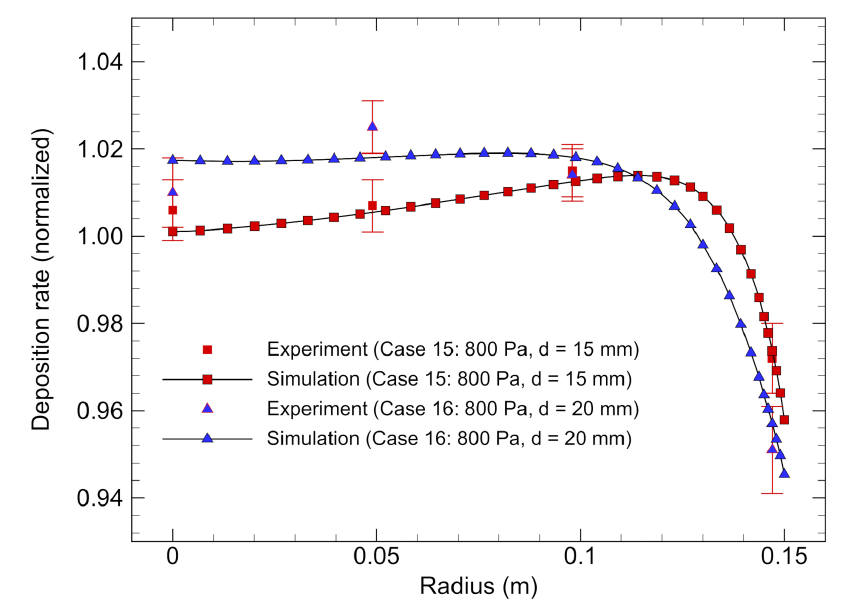
Figure 8. Effect of the electrode spacing on the deposition rate. Deposition rate profiles for Cases 15 ( d = 15 mm) and 16 ( d = 20 mm) are